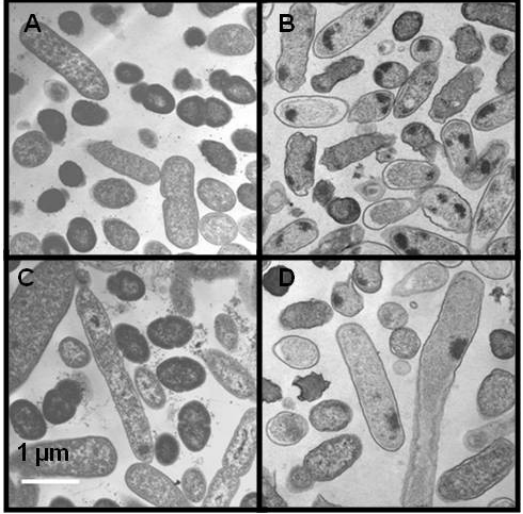
Figure 5. Transmission electron micrographs in the absence ( A , B ) or presence ( C , D ) of 0.05  g/mL enrofloxacin for S. enterica ( A , C ) and L. monocytogenes ( B , D ). Scale bars indicate a length of 1 